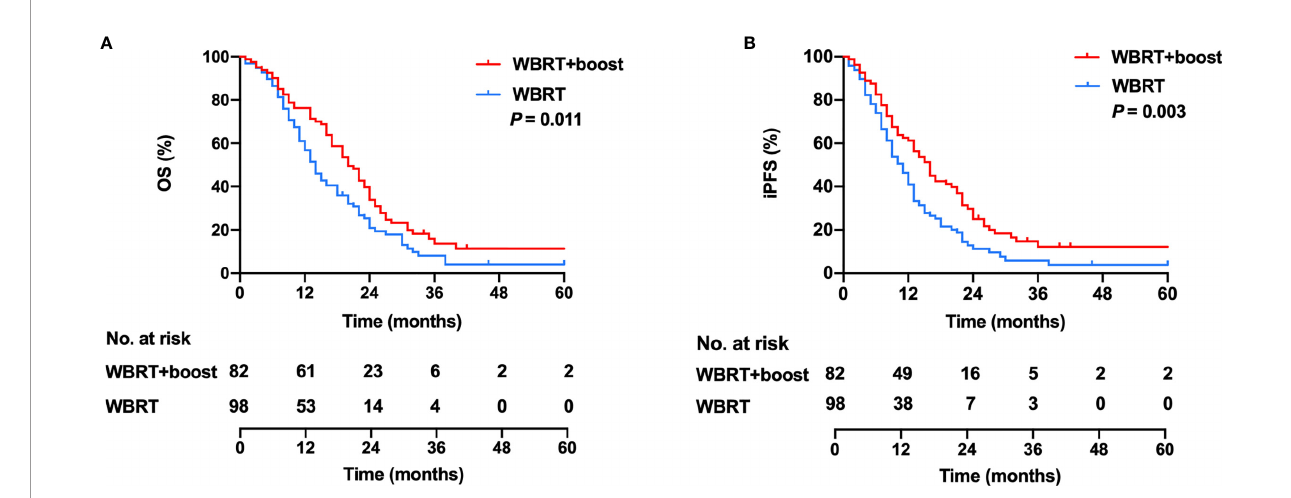
FIGURE 3 | Kaplan – Meier curves for OS (A) and iPFS (B) in the WBRT and the WBRT + boost